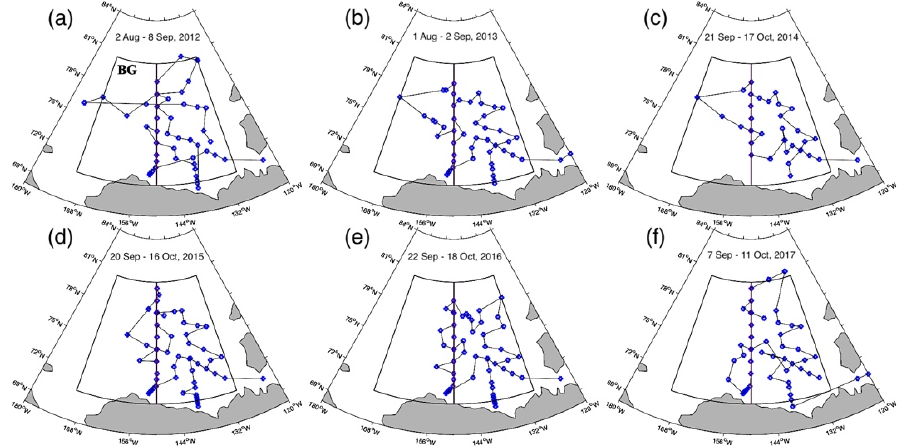
Figure 1. Map of the Beaufort Gyre Exploration Project (BGP) CTD casts (blue dots) from ( a – f ) 2012–2017 in the (black outline) Beaufort Gyre (BG). The line along 150°W delineates the transect between 70.5°N and 80.5°N.